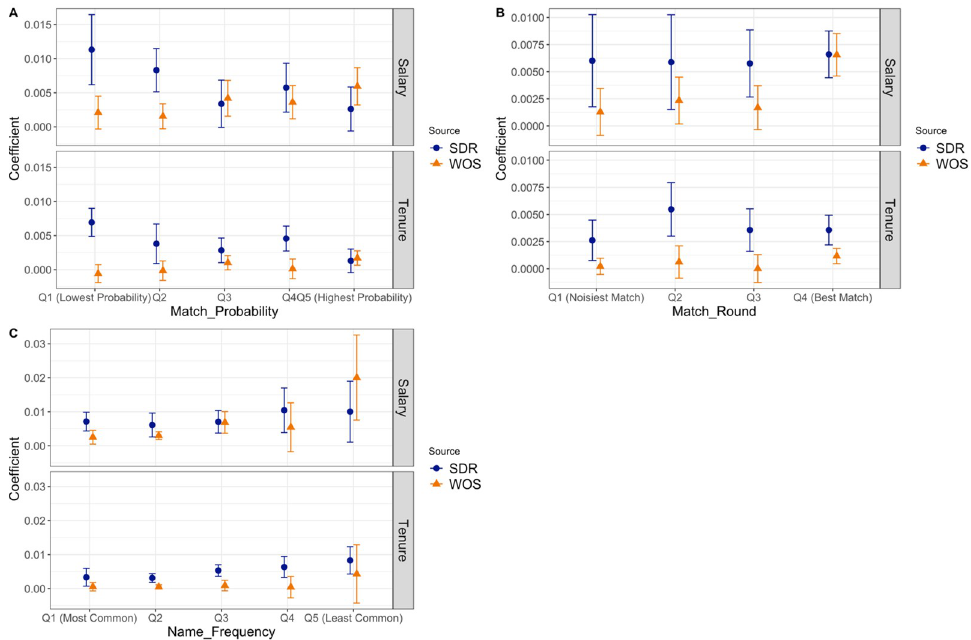
Fig 5. Relationship between outcomes and SDR and WoS publication counts by match quality measures. Notes: Each sub-figure plots the coefficients and 95% confidence intervals of the coefficients from regressions of ln(Salary) (upper panel) and an indicator for tenure status (lower panel) on publication counts from the SDR and WoS using 2003 SDR data. Each panel reports estimates from 4 or 5 separate regressions stratified by measures of match quality. In sub-figure A, estimates are stratified by the mean match probability among all of a respondent’s publications. From the left to right, the bins are [0.5000, 0.6901], [0.6902, 0.7568], [0.7568, 0.8128], [0.8128, 0.8693], [0.8693, 1]. In sub-figure B, the estimates are stratified by the mean match round of an author’s publications with lower match rounds representing higher confidence. From the left to the right, the bins are [1.768, 2], [1.3076, 1.767], [1, 1.3076], [0, 1]. (We stratify the data by quartiles instead of quintiles because the first quartile has a large cluster at 1.) In sub-figure C, the estimates are stratified by name frequency (first initial and last name of the SDR respondent), with higher frequency names being more ambiguous. From the left to the right, the bins are [1423, 218422], [282, 1423], [83, 281], [25, 82], [1, 24].